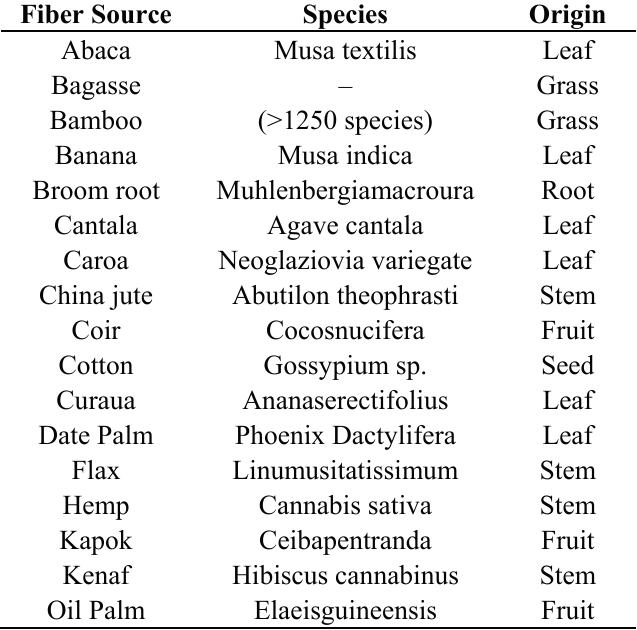
Table 1. List of important biofibers. Reprinted with permission from Elsevier, 2008